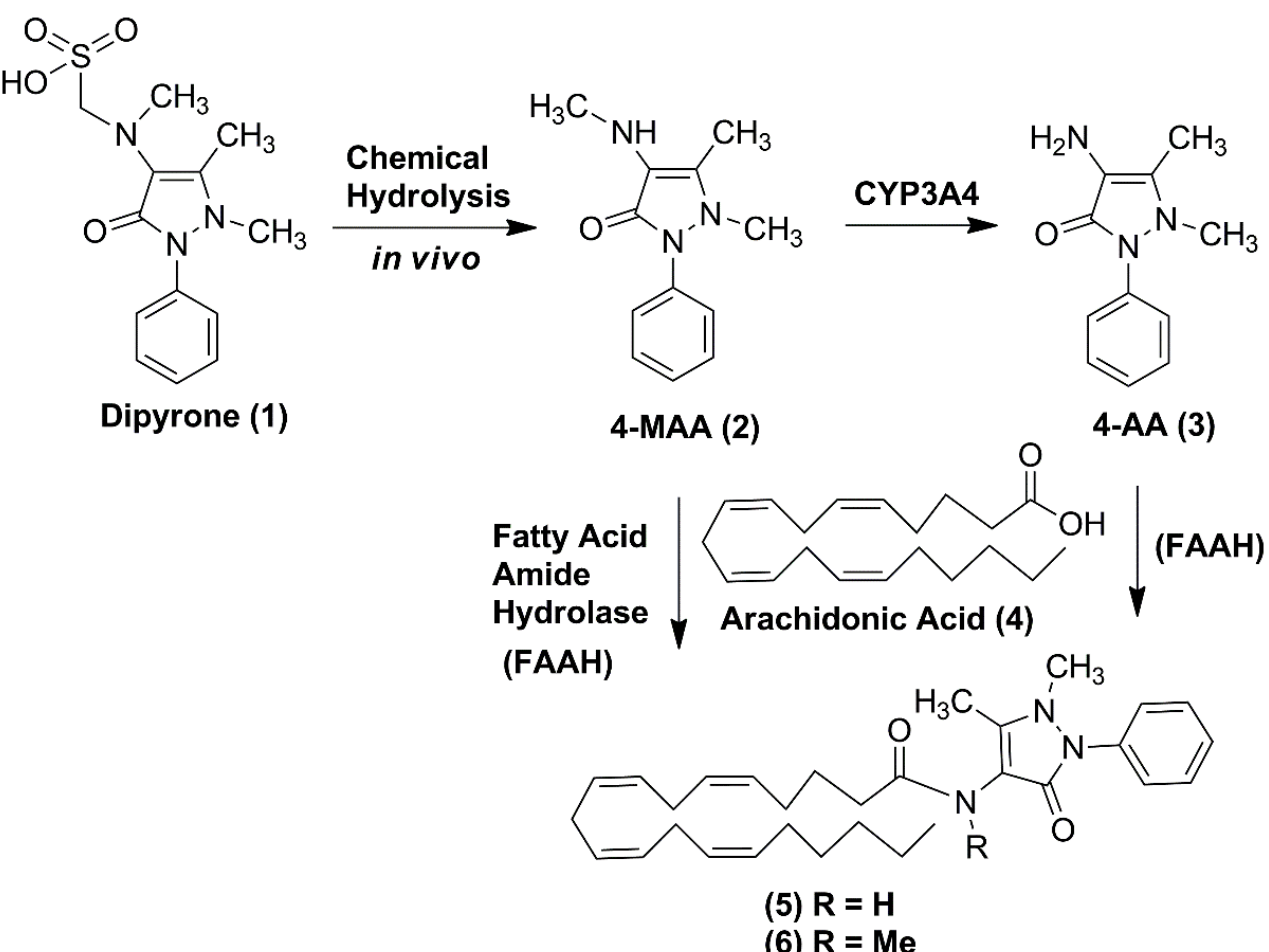
Figure 1. Dipyrone ( 1 ) and its active metabolites 4-methylaminoantipyrine (4-MAA, 2 ) and 4- aminoantipyrine (4-AA, 3 ) with their corresponding arachidonyl-pyrazolamides ( 5 ) and ( 6 ), respectively.